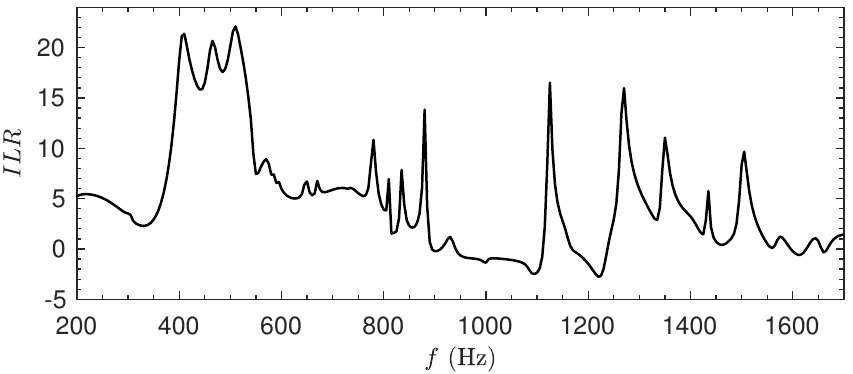
Figure 8. ILR of the system with